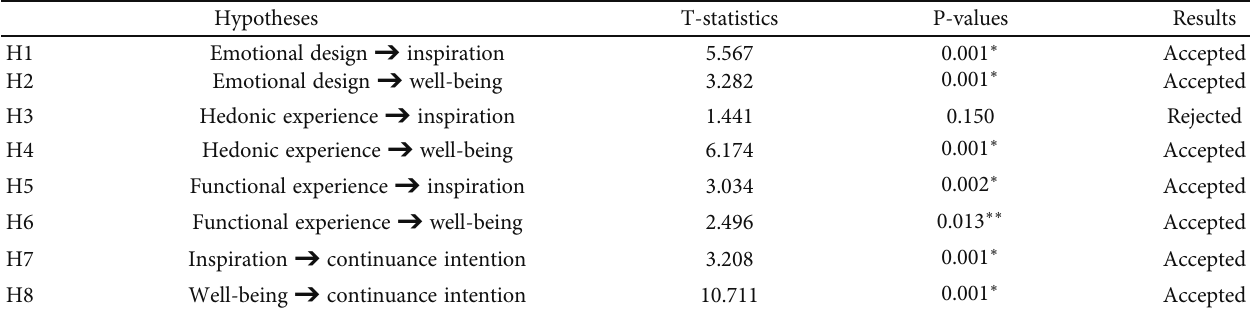
Table 5: Structural model evaluation.